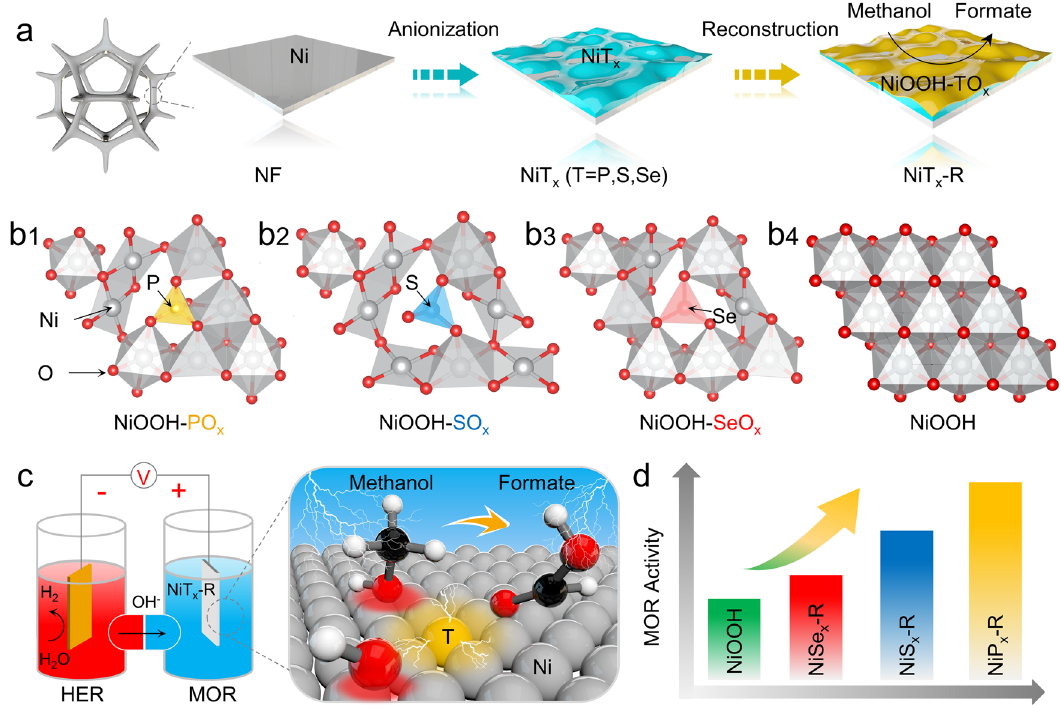
Fig. 1 Synthesis of oxyanions-coordinated NiOOH through in situ surface recon fi guration towards MOR. a Schematic drawing of the synthesis route of NiT x -R electrocatalysts (T = P, S, and Se. And R means surface reconstruction) doped with different oxyanions on the surface NiOOH species (NiOOH- TO x ) through surface anionization of nickel foams to prepare NiT x , followed by in situ electrochemical oxidation in the alkaline. b 1 – b 4 Optimized structural models of oxyanions-doped NiOOH and pure NiOOH. c Schematic illustration for an H-type electrolytic cell and the related transformation mechanism of MOR for the NiT x -R electrocatalyst. d MOR activity comparison of pure NiOOH, NiP x -R, NiS x -R, and NiSe x -R. The results imply that